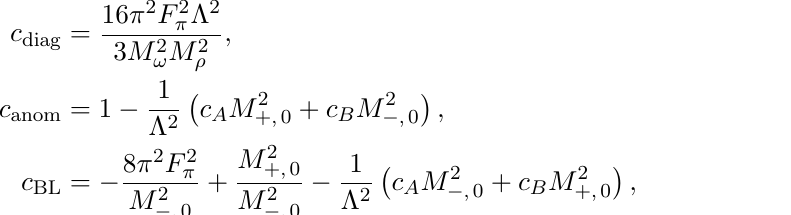
Figure 22. (cid:25) 0 TFF in the full space-like region for Q 2 model, (4.10), is shown in the left panel, and our alternative model, (B.1), is shown in the right panel.